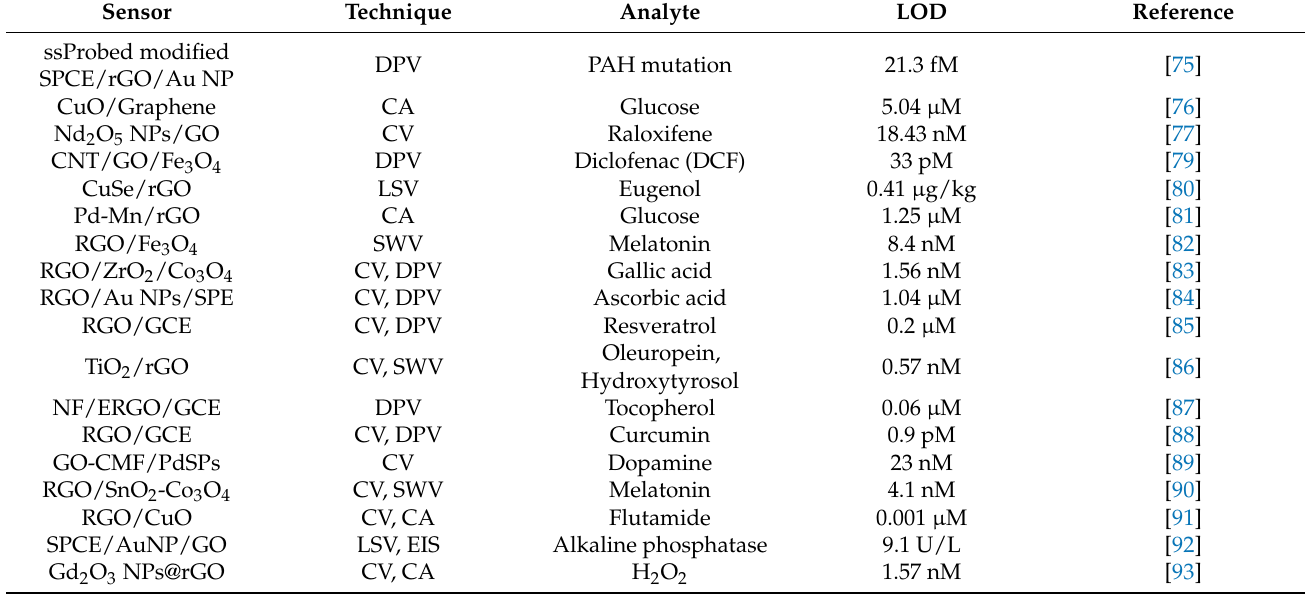
Table 2. Graphene based